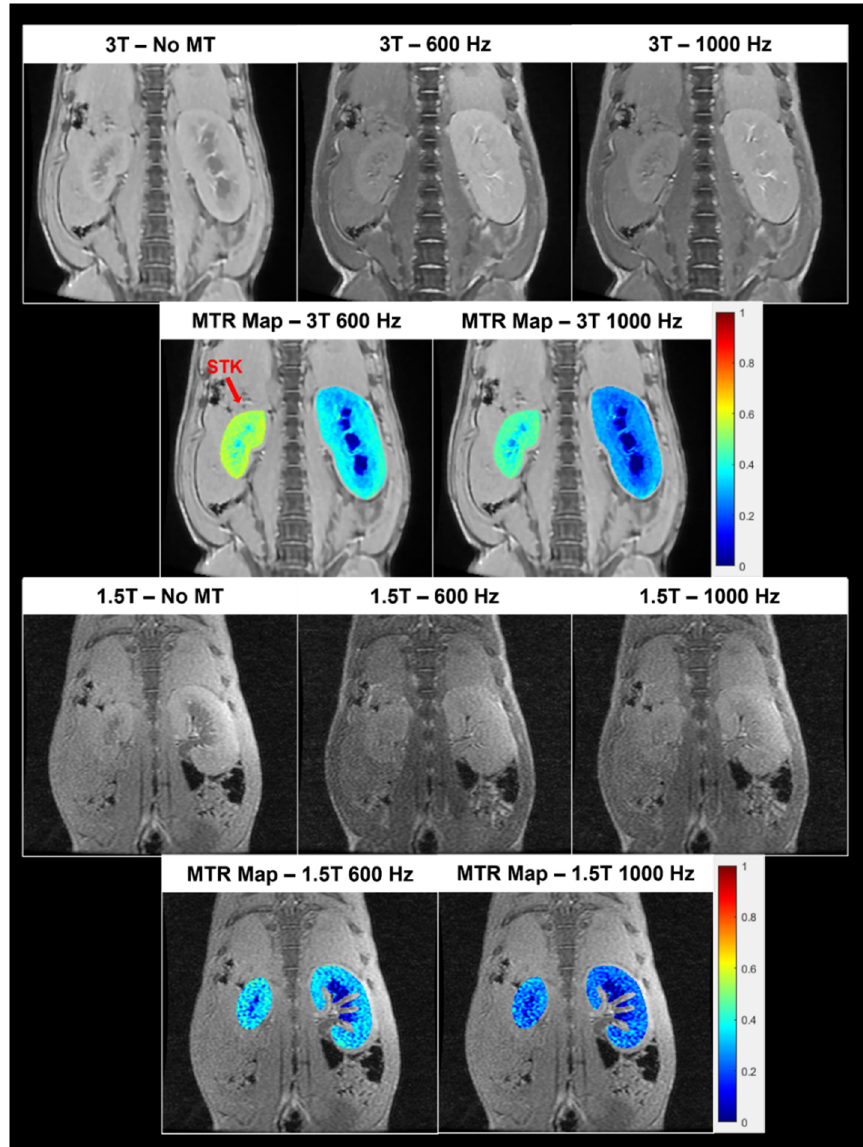
Figure 1. Top. Representative MT images from a pig without MT pulse (i.e., M 0 ) and with MT pulse (i.e., M T ) at 600 or 1000 Hz offset frequencies at 3T, as well as the corresponding MTR maps overlaid on the images. Bottom, M 0 and M T images from the same pig at 1.5T, and the corresponding MTR maps. MTI at 3T shows better image quality than MTI at